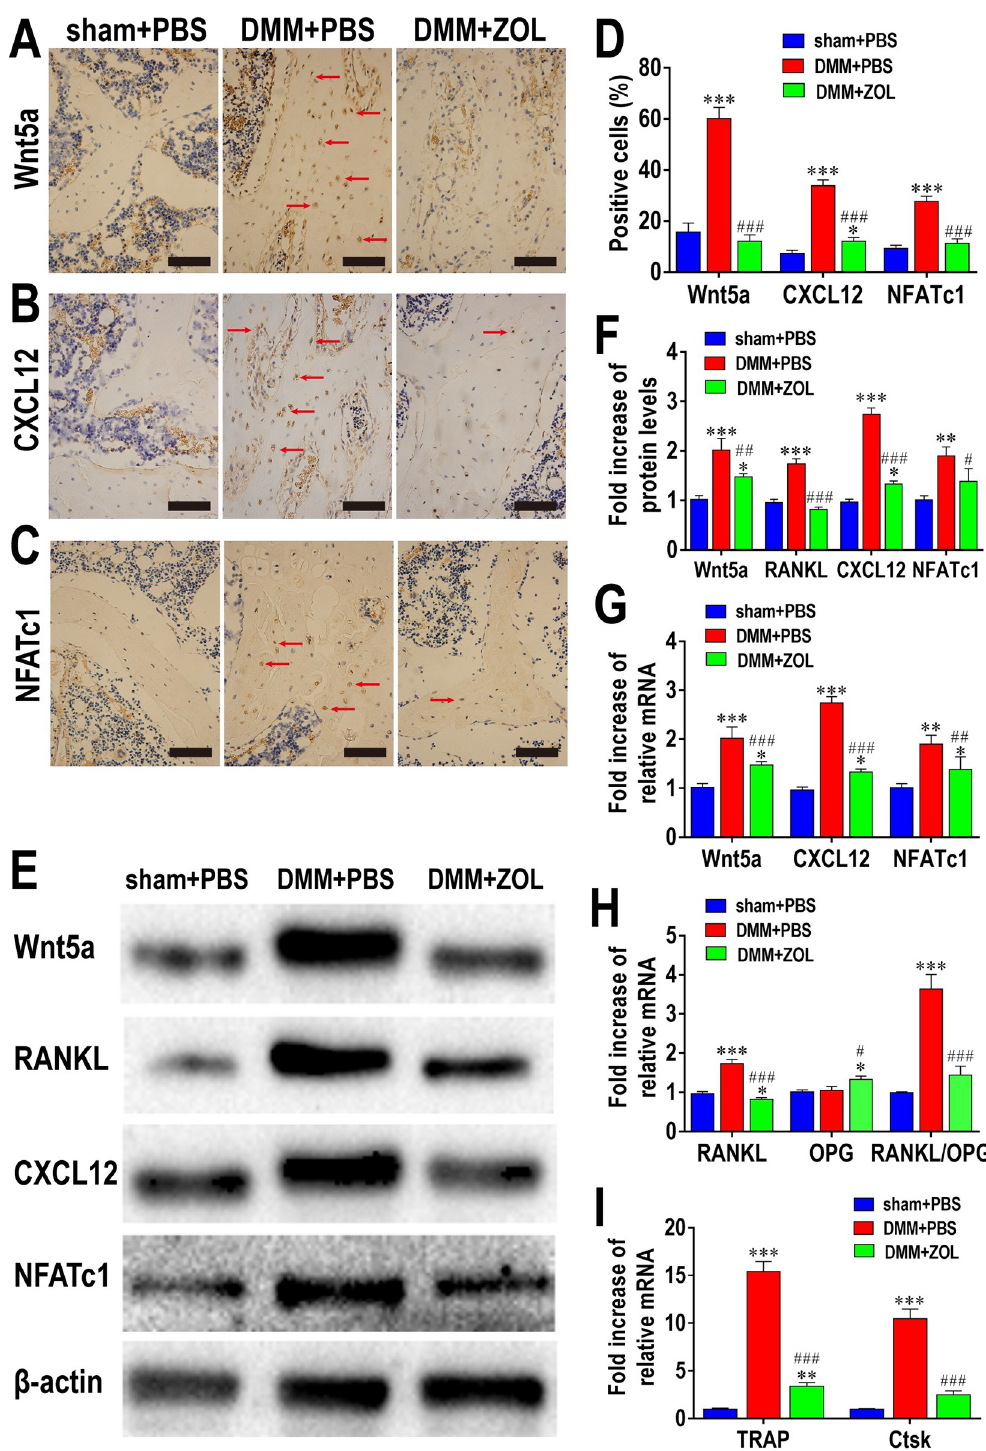
Fig 7. ZOL attenuates the expression of Wnt5a and osteoclastogenesis genes 4 weeks after DMM-induced OA. Expression of (A) Wnt5a, (B) CXCL12 and (C) NFATc1 determined by immunohistochemical staining and by (E) quantitative analysis. Scale bar, 200 μ m. n = 6 per group. (D) Western blots and (F) quantitation of Wnt5a, RANKL, CXCL12 and NFATc1. Reverse transcription quantitative polymerase chain reaction of (G) Wnt5a , CXCL12 , NFATc1 , (H) RANKL , OPG , RANKL/OPG and (I) TRAP , Ctsk . n = 3 per group. � P < 0.05, �� P < 0.01, and ��� P < 0.001, compared with sham+PBS group; # P < 0.05, ## P < 0.01, and ### P < 0.001, compared with DMM+PBS